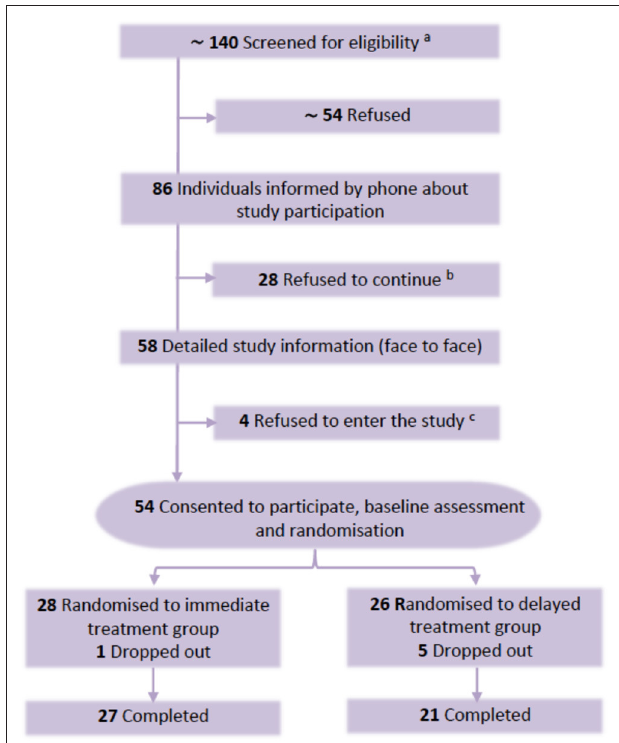
FIGURE 2 | CONSORT diagram of participant flow. a Due to changes in study personnel and pandemic problems the number of screened patients had to be estimated retrospectively from exact numbers of the main recruiting physician. b Refused after detailed information by phone about study. Reasons for refusal: study requirements such as filling in questionnaires ( n = 18); not wanting the intervention ( n = 6); mental or physical problems ( n = 4). c Refused after detailed face to face information: study requirements (n = 2); mental or physical problems ( n =